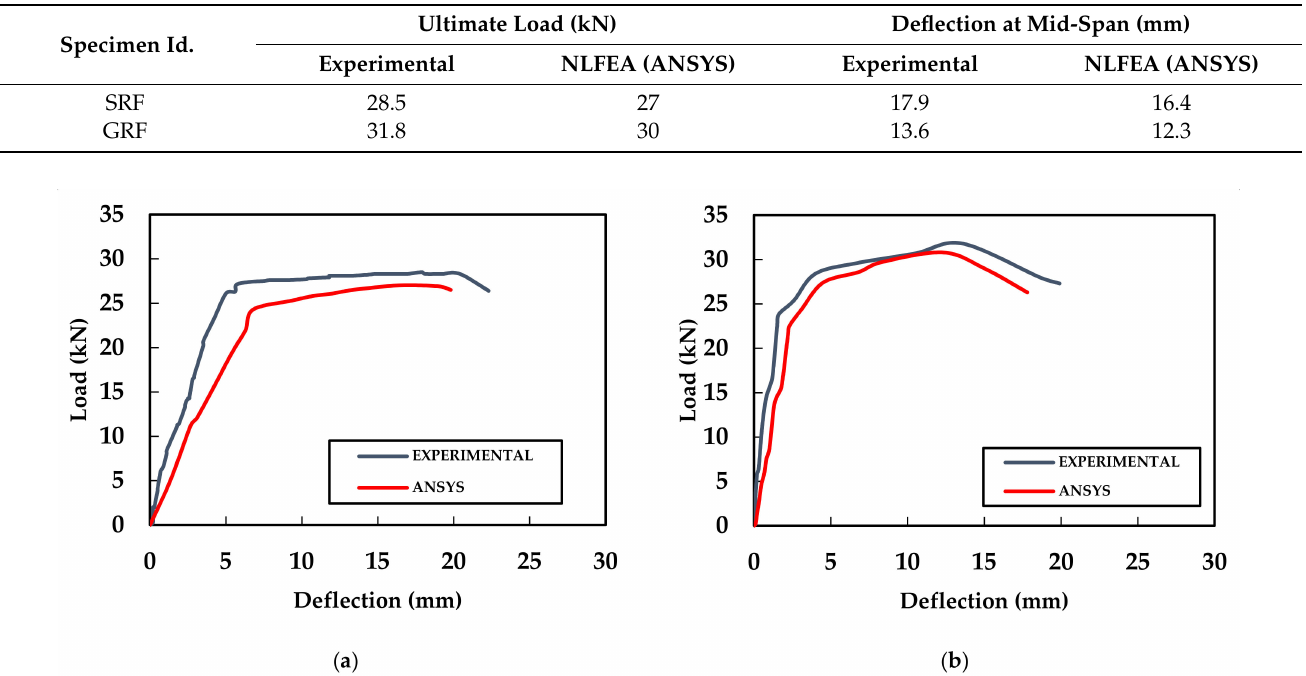
Figure 19. Comparison between experimental and numerical load–deflection behavior of ( a ) SRF and ( b )